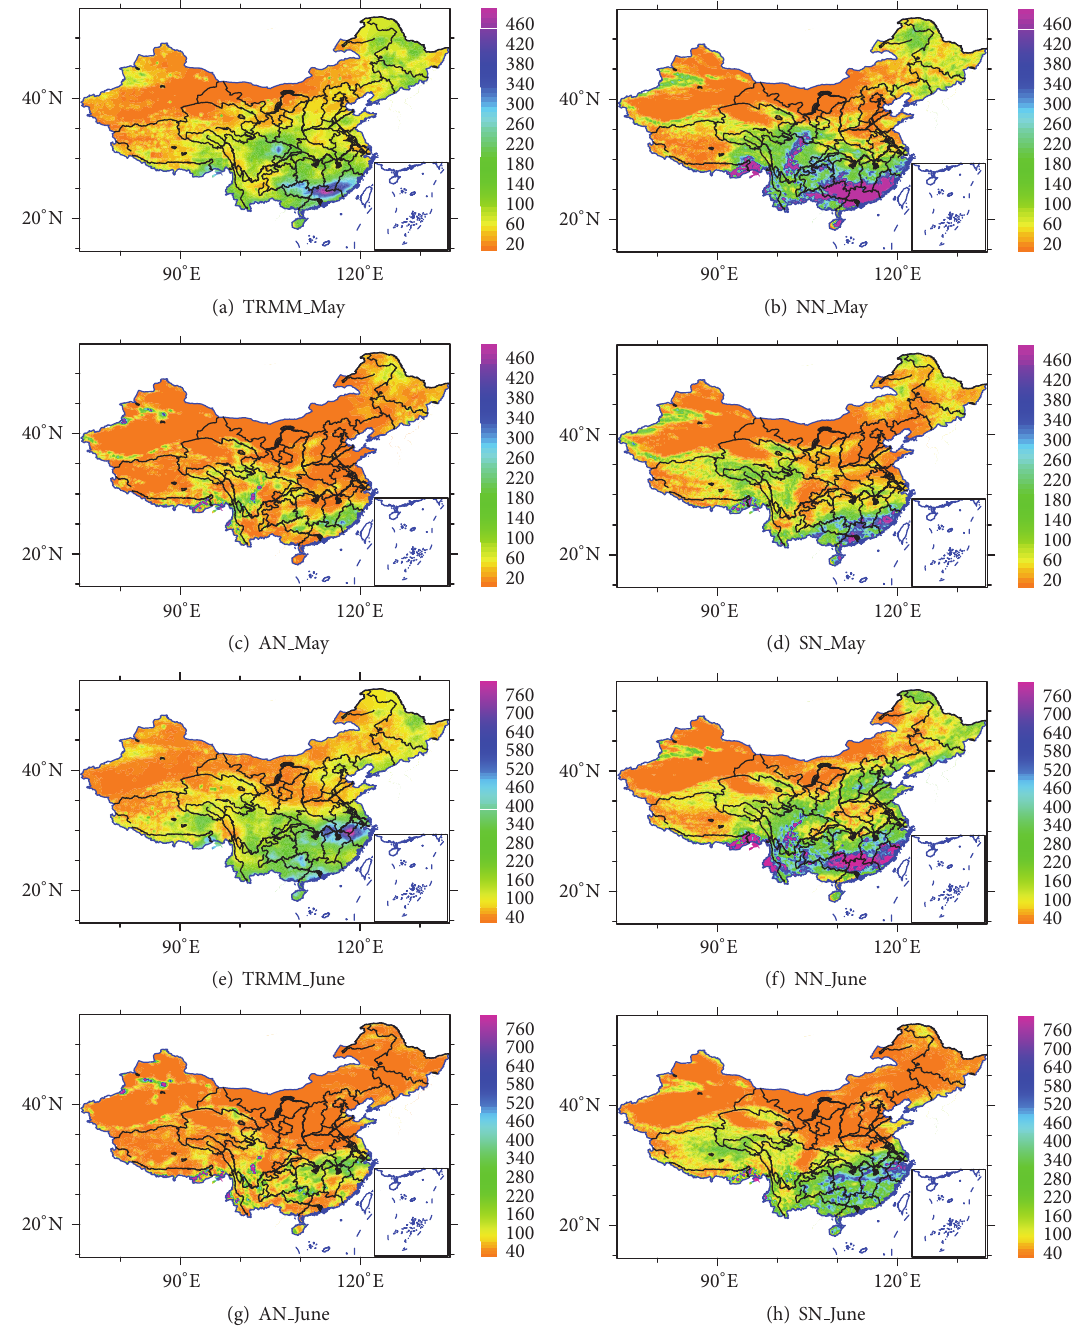
Figure 2: Comparison of monthly accumulated precipitation (mm) for (a), (e) TRMM observed precipitation (TRMM), (b), (f) WRF simulated precipitation with no nudging (NN), (c), (g) WRF simulated precipitation with analysis nudging (AN), and (d), (h) WRF simulated precipitation with spectral nudging (SN) for May 2011 ((a)–(d)) and June 2011